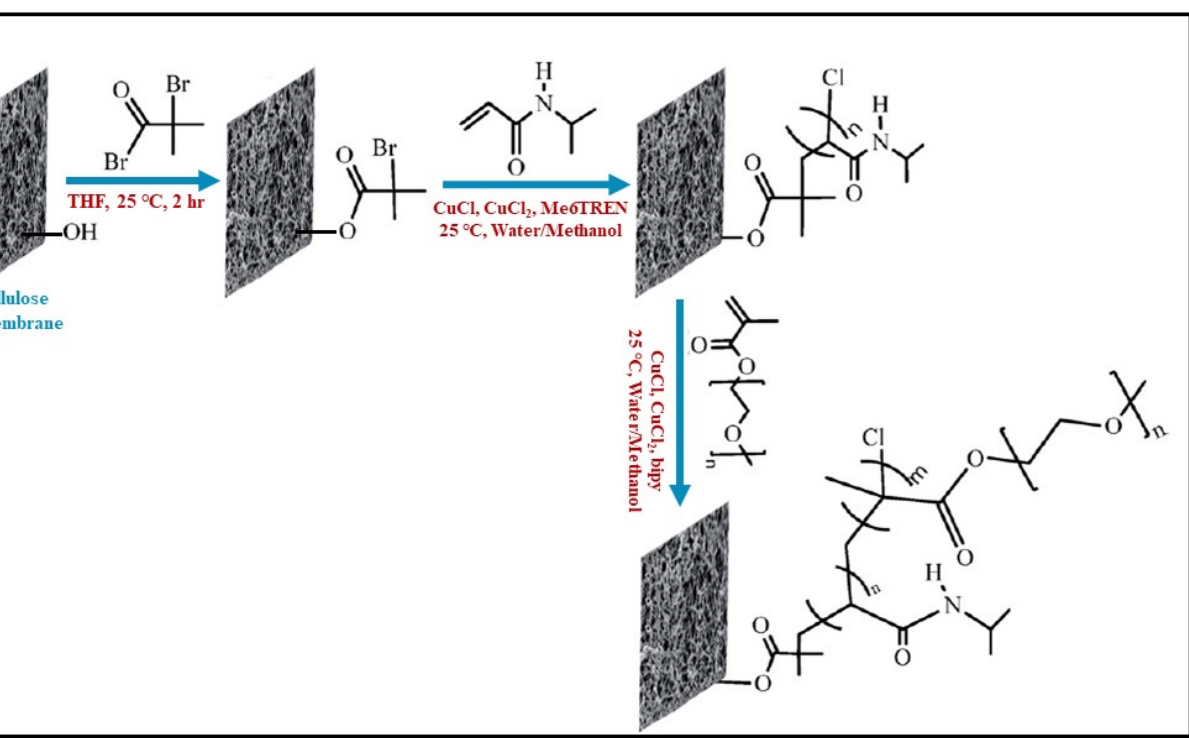
Figure 9. Schematic diagram of surface-initiated ATRP of poly (N-isopropylacrylamide) (PNIPAAm)-block-poly (oligoethylene glycol methacrylate) (PPEGMA) from cellulose Reprinted with permission from ref. [36]. © 2011 Elsevier B.V.